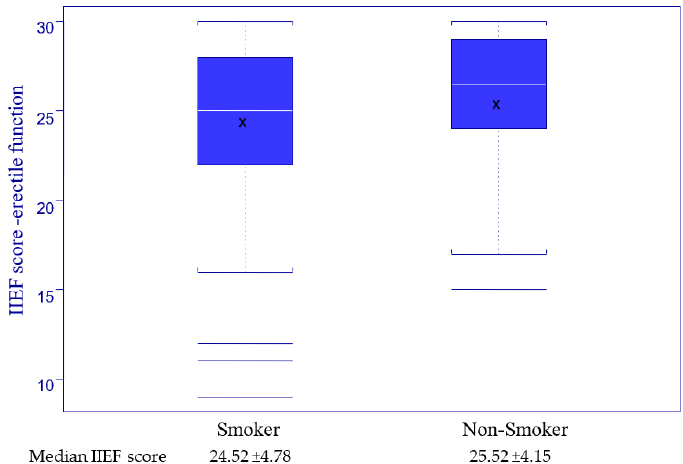
Figure 4. IIEF score (erectile function) distribution related to smoking. Table 4. Correlation between smoking/blood glucose and ED.